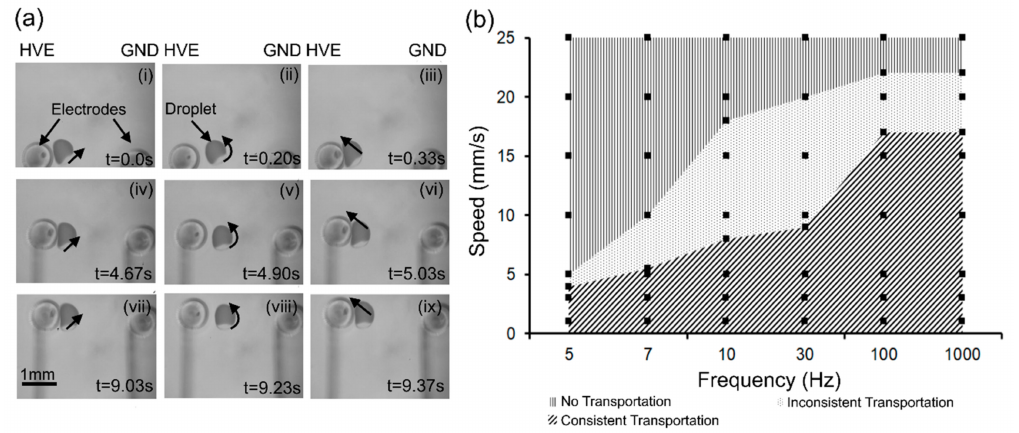
Figure 4. The utilization of electrical tweezer for the droplet transportation: ( a ) Sequential images (i–ix) illustrates the droplet transportation meanwhile the droplet is oscillating with the high-voltage electrode under the influence of electric potential of 480 V (V/d = 120 V/mm) at 3 Hz; ( b ) the characterization of droplet transportation with the electrical tweezer (electrodes 10 mm apart), under the influence of electric potential of 2000 V (V/d = 200 V/mm) at 5 Hz, is categorized into three regions; (i) no transportation, (ii) inconsistent transportation, and (iii) consistent